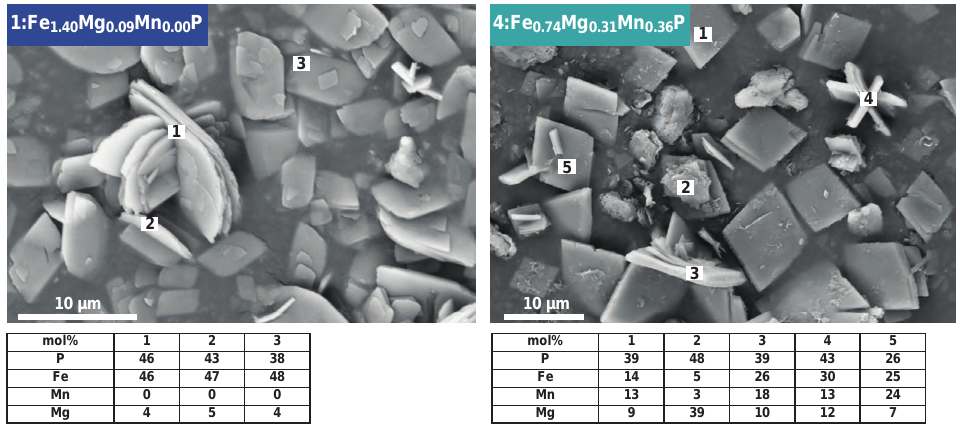
Figure 10. Examination of precipitates 1 and 4 at the start of the sulfidization experiment by SEM-EDS, including imaging and elemental concentrations in mol%. The precipitates also contained some sodium, chloride and sulfur (data are given in Table S1 in the